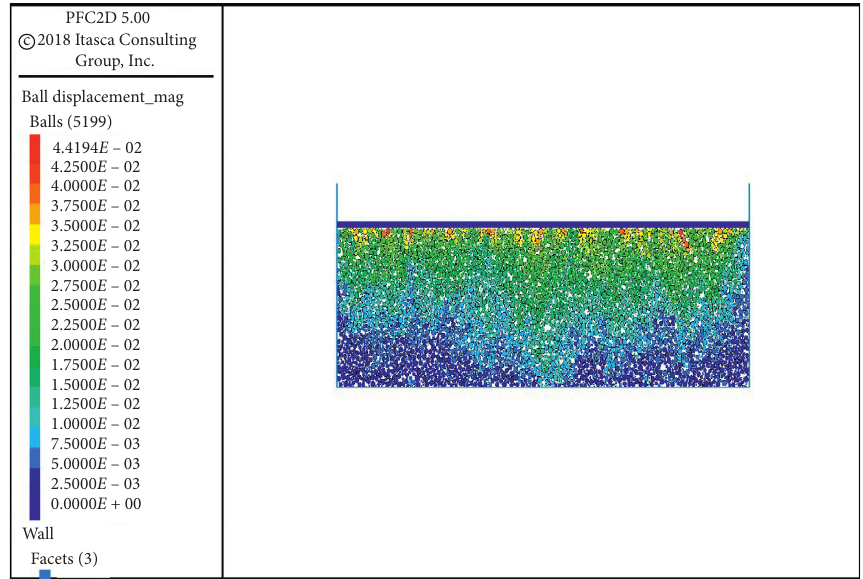
Figure 17: Discrete element particle migration map of 50 cm thick reclaimed soil with five compactions.